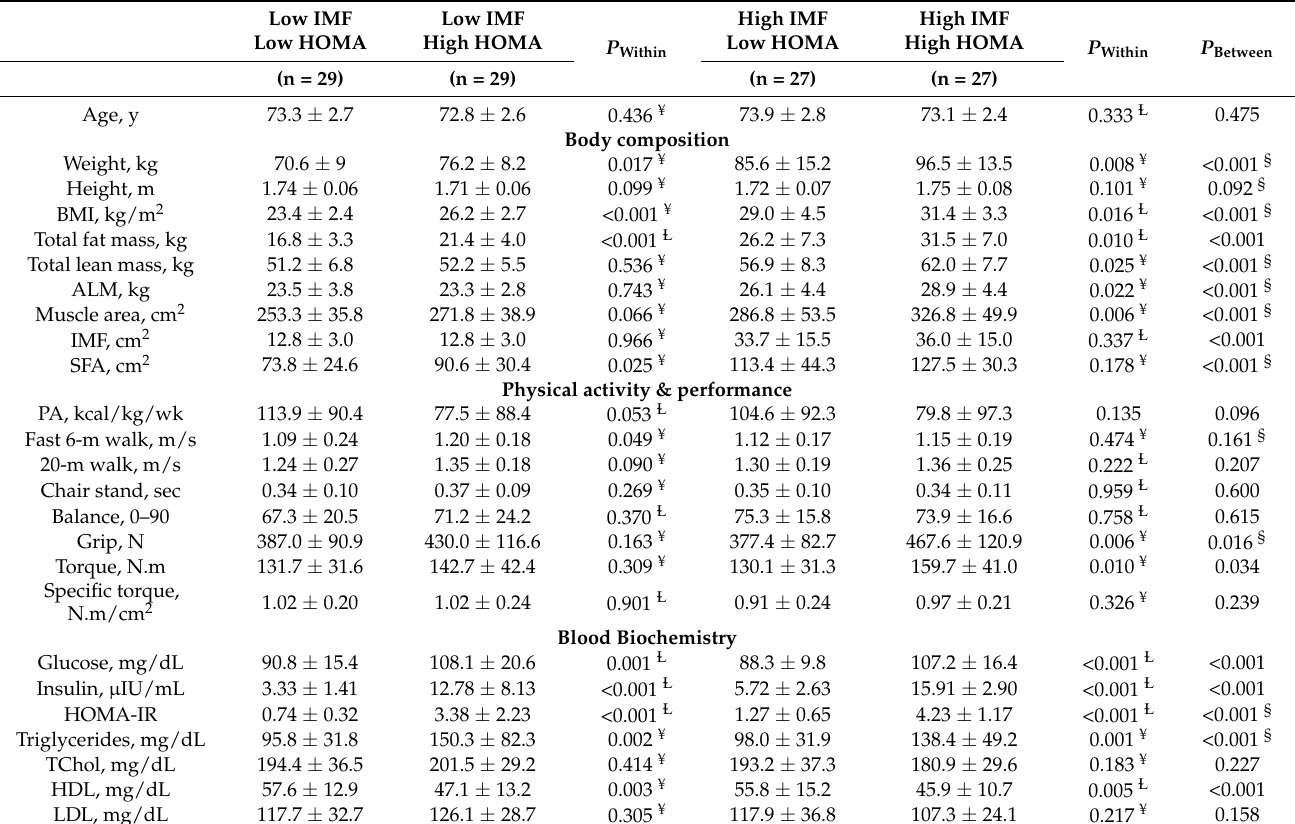
Figure 2. Representation of the 118 circulating metabolites associated with Homeostasis Model Assessment of Insulin Resistance (HOMA-IR) and their levels across HOMA-IR quartiles, after adjusting for age, weight, physical activity, med- ications, and smoking and accounting for multiple comparisons (false discovery rate 0.25). Table 2. Body composition, physical function, and blood biochemistry of older adults with the same level of intermuscular fat area but different levels of insulin sensitivity (resistance versus sensitive).